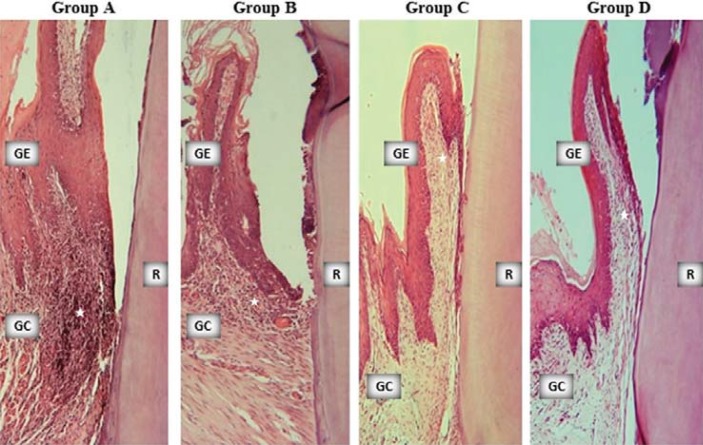
Sample microphotographs from the study groups (x10, hematoxylin-eosin). Stars indicate inflammatory cell infiltrate. GE: gingival epithelium, GC: gingival connective tissue, R: tooth root